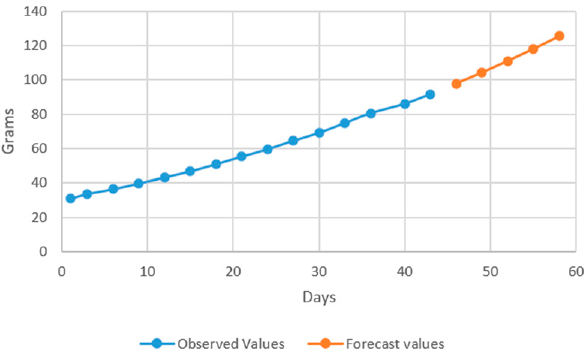
Figure 8. The evolution of Acipenser baerii biosmas in B technological scenario. The models for Acipenser baerii biomass forecasting are presented in Equation (1), for A technological scenarios and Equation (2) for B